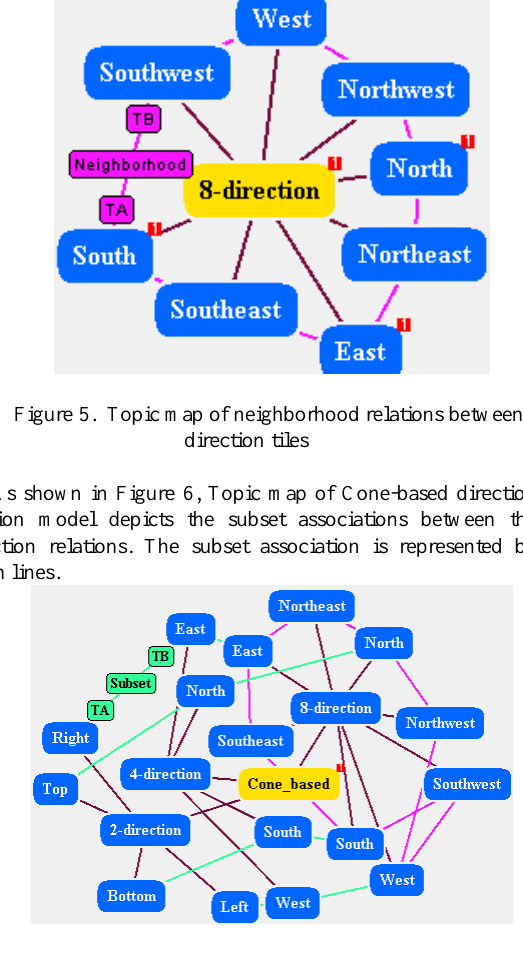
Figure 6. Topic map of Cone-based direction relation model (4) As shown in Figure 7, Topic map of 4I model and 9I model depicts the corresponding associations between 4-intersection